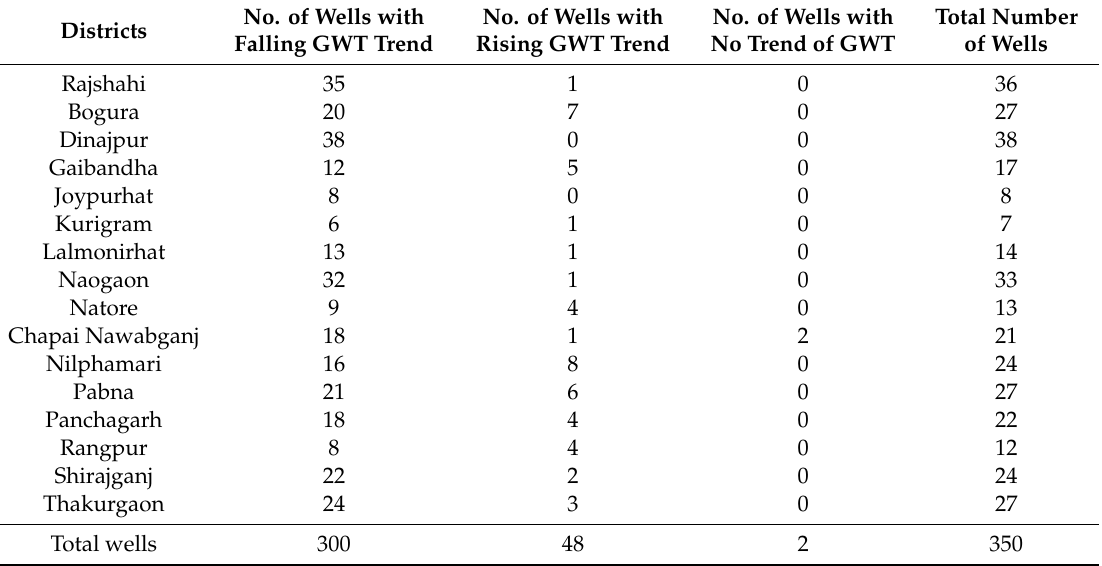
Table 1. Number of groundwater table (GWT) monitoring wells in 16 districts of the North-West hydrological region of Bangladesh with falling, rising, and no trends of the annual maximum depths of GWTs from ground